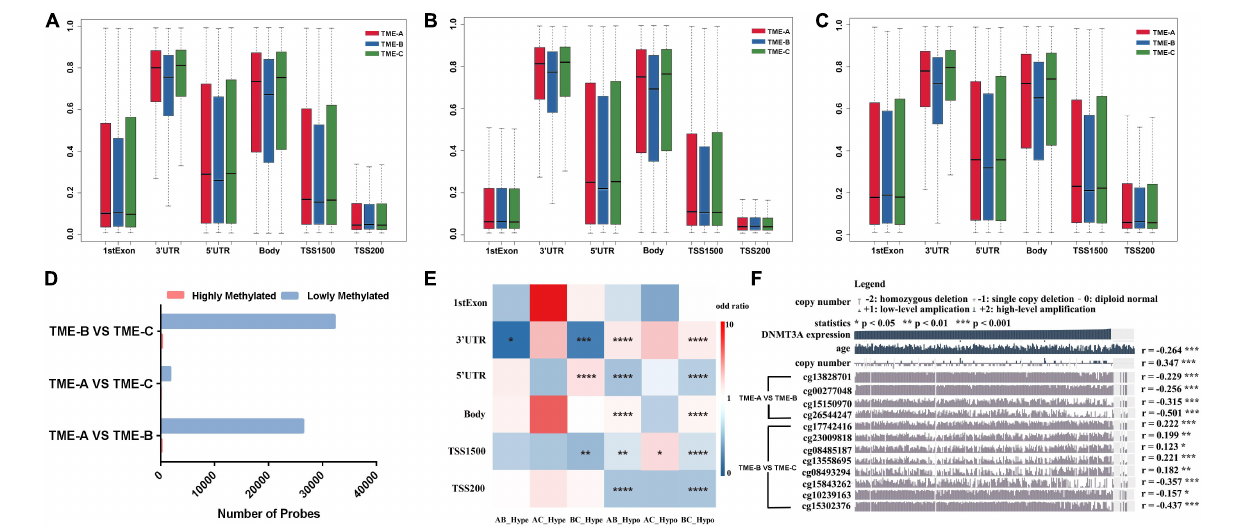
FIGURE 5 | DNA methylation differences among the three TME groups. (A) Probe distribution of mean β value across differentially DNA methylated regions classified by gene annotations. The vertical axis represents the mean methylation value. (B) The mean β values of probes annotated to upregulated genes in the TME-B group versus the TME-C group across six genomic regions. (C) The mean β values of probes annotated to downregulated genes in the TME-B group versus the TME-C group across six genomic regions. (D) The number of hypermethylated and hypomethylated probes among TME groups. (E) The performance of hypermethylated and hypomethylated probes on genomic region enrichment based on six pairs of TME groups. The number of hypermethylated, hypomethylated, and total probes are calculated, and the odds ratio is calculated by Fisher’s test and Chi-square test shown by heatmap. The P value is labeled with asterisks in each grid (**** P < 0.0001, *** P < 0.001, ** P < 0.01, * P < 0.05, and ns: no significance). The horizontal axis indicates that hypomethylated probes or hypomethylated probes in TME groups (AB represents that TME-A versus TME-B; AC represents that TME-A versus TME-C; BC represents that TME-B versus TME-C; Hype represents hypermethylated probes; Hypo represents hypomethylated probes). (F) Correlation between DNMT3A expression and age, as well as between copy number and DNA methylation CpG sites. The age is at initial pathologic